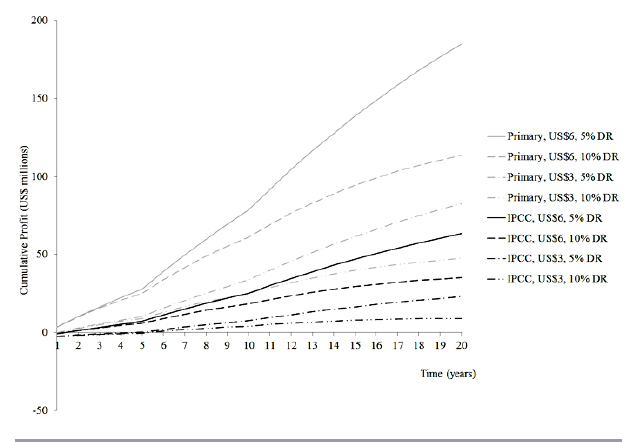
Fig. 4 . Estimated cumulative profits over the Bale Mountains REDD project lifespan showing primary and secondary IPCC data under variable carbon price and discount rates